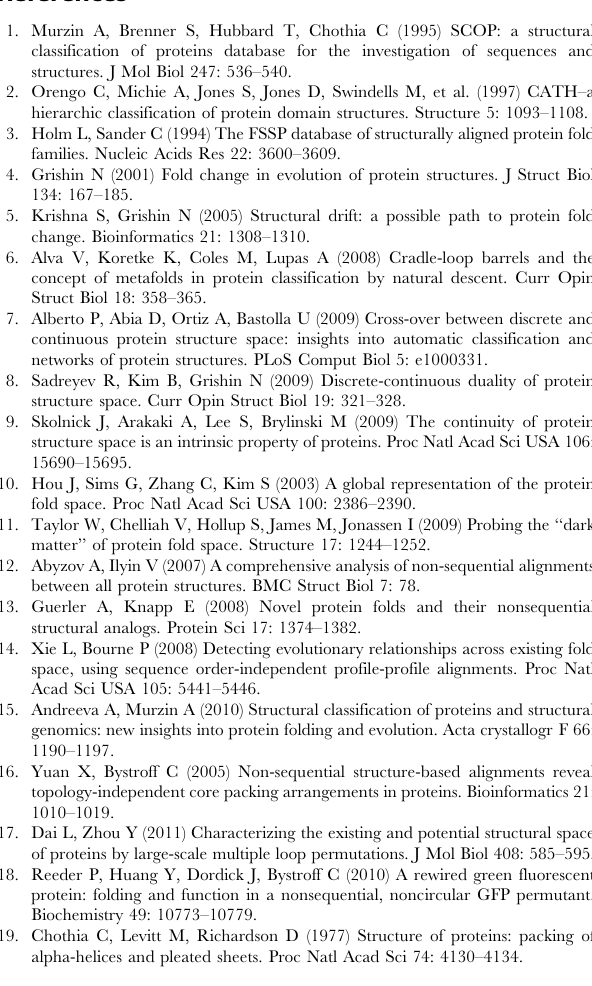
Figure S1 Target size dependence with various cutoff values. The percentage of the target proteins with a TM-score of the SQ(A), RW(B), and RR(C) templates equal to or greater than various cutoff values as a function of the target protein size. The lines are colored red, yellow, black, green, and cyan for TM-score thresholds of 0.46, 0.48, 0.50, 0.52, and 0.54, respectively. The horizontal axis represents the sequence length of the target proteins. The vertical axis represents the percentage of the target proteins with TM-scores of SQ, RW, and RR templates equal to or greater than the TM-score threshold for a given target size. Figure S2 Graphical representation of the protein fold universe with various cutoff values. The detailed graphical representations of the protein fold universe and the simplified networks drawn by the SQ, RW, and RR schemes with cutoff values of 0.46, 0.48, 0.50, 0.52, and 0.54. Figure S3 Relationship between the MCC value and the threshold. The relationship between the MCC value to decide